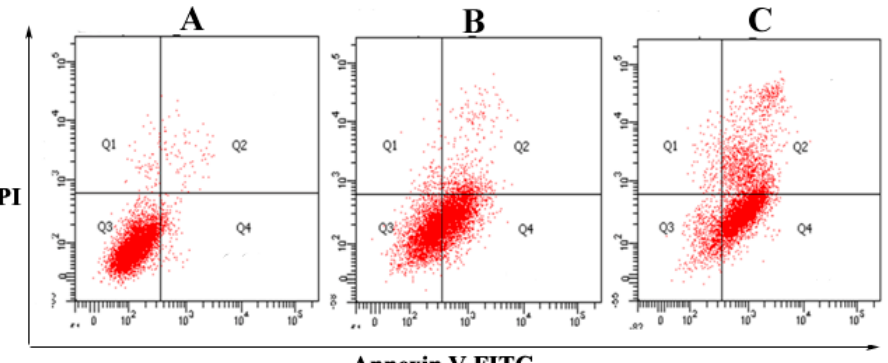
Figure 3. Flow cytometric analyses of A. spinosus fatty acid-induced apoptosis in HepG2 cells using annexin V-fluorescein isothiocyanate (FITC)/propidium iodide (PI). Quadrants: Q3 (normal cells), Q4 (apoptotic cells), Q2 (late apoptotic/necrotic cells). The mean apoptotic population for ( A ) control (normal cells); ( B ) 25 µmol/L; and ( C ) 60 µmol/L of fatty acid-treated HepG2 cells in 24 h, respectively.